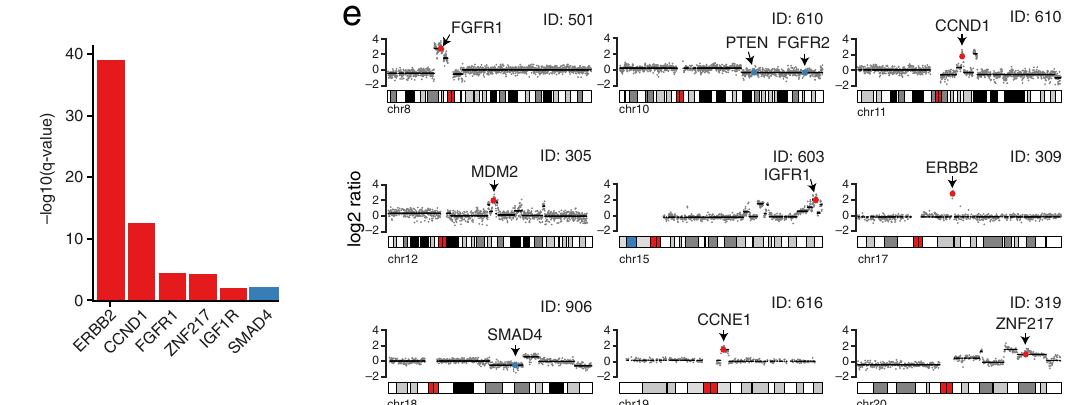
Fig. 4 Copy number alteration distribution and frequency in FFPE samples using the CUTseq method. Percentage ( a ) and size ( b ) of the altered genome (ampli fi ed or deleted) in the SBG-2004-1 study. In the boxplots, each box extends from the 25th to the 75th percentile, the midline represents the median, and the whiskers extend from – 1.5× IQR to + 1.5× IQR from the closest quartile, where IQR is the inter-quartile range; c Landscape of the most frequently altered chromosomal arm and gene loci among study samples; d , e Signi fi cantly focally altered genes in relation to their chromosomal